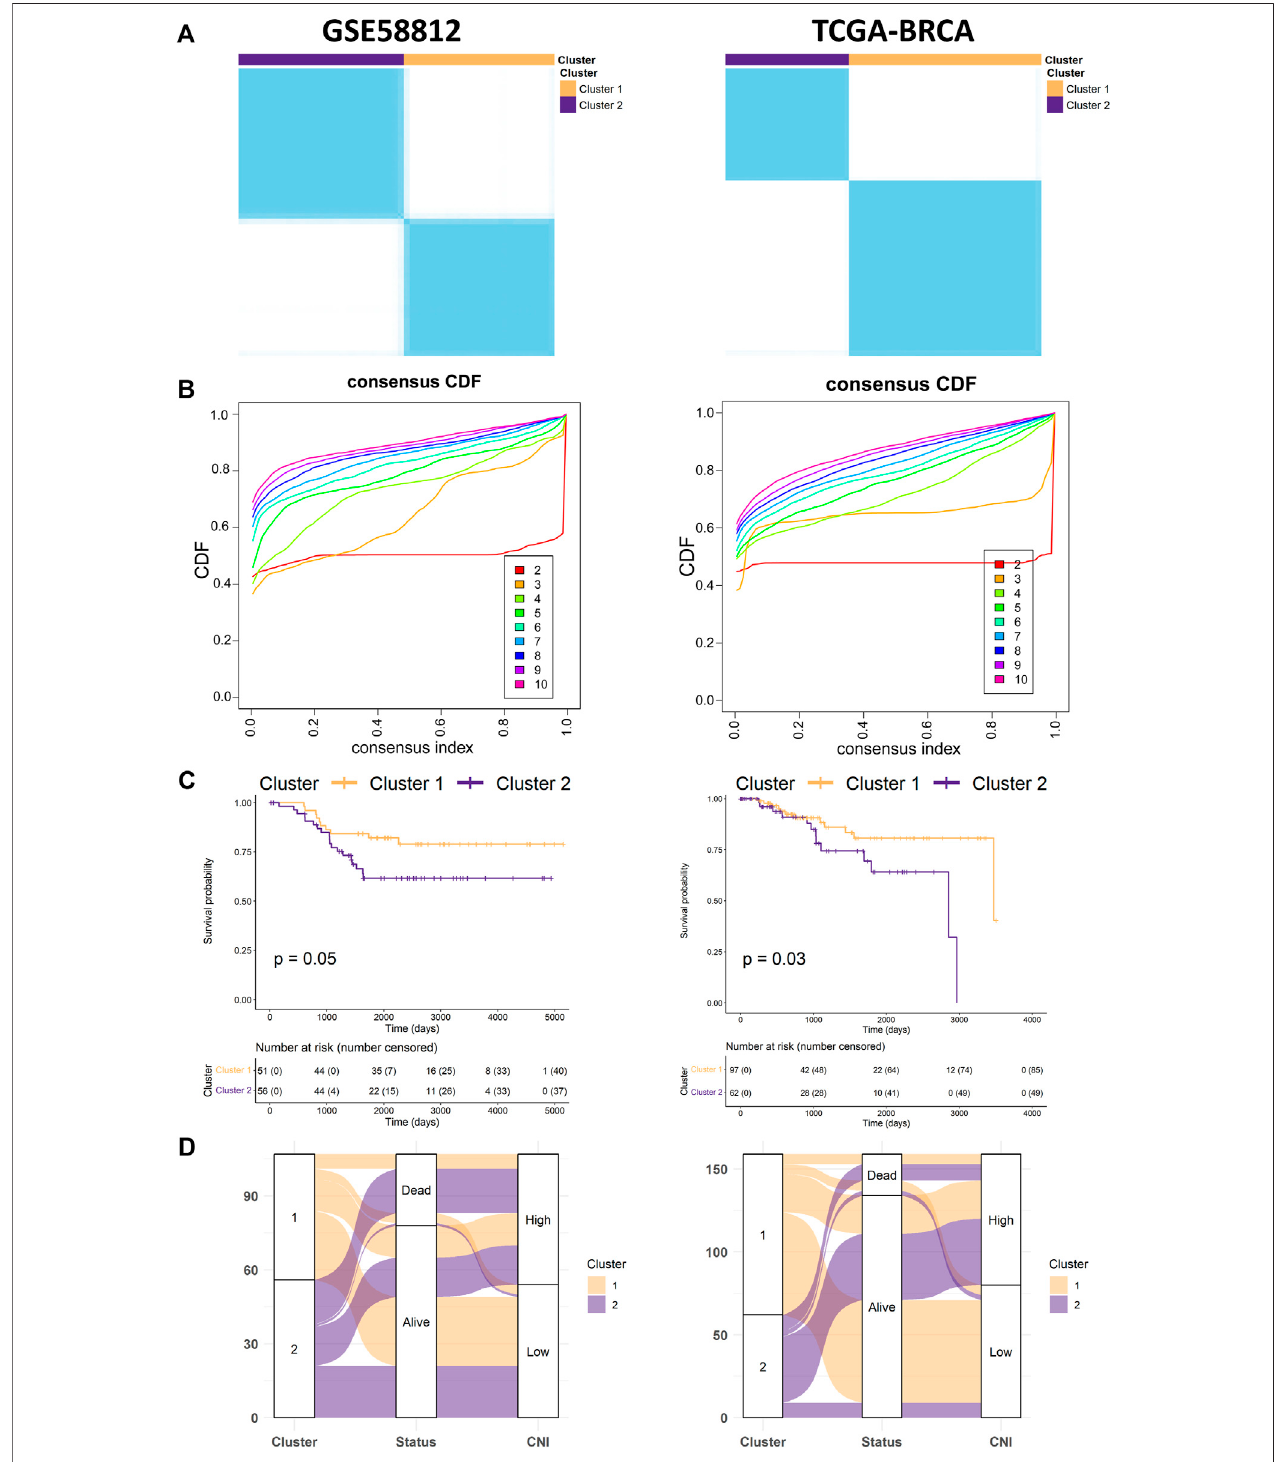
FIGURE 7 | Identi fi cation of potential subgroups using unsupervised consensus clustering. (A,B) Consensus clustering matrixes and cumulative distribution function(CDF)plots,whichfound k =2wastheoptimalclusternumbernotonlyinthetrainingcohort(left)butalsointhevalidationcohort(right). (C) Kaplan – Meiersurvival curvesforOSoftheTNBCpatientswithcluster1andcluster2inthetraining(left)andvalidationcohorts(right). (D) Thealluvialdiagramfullydemonstratedthecorrelation of prognosis between the clusters and CNI values in both the training set (left) and validation set (right).